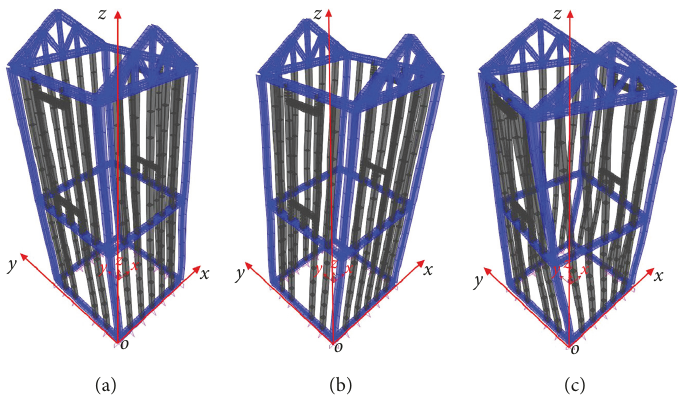
Figure 22: Modal for the experimental model. (a) First-order modal. (b) Second-order modal. (c) Third-order